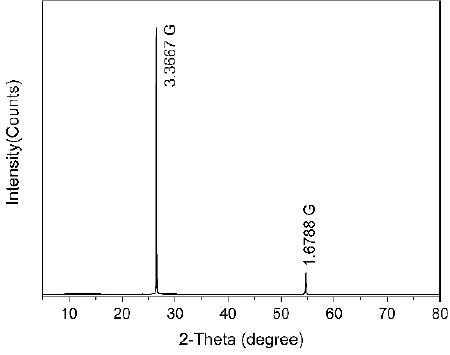
Figure 1. XRD pattern of the graphite sample. Table 2. Chemical compositions of the graphite mineral (wt%).